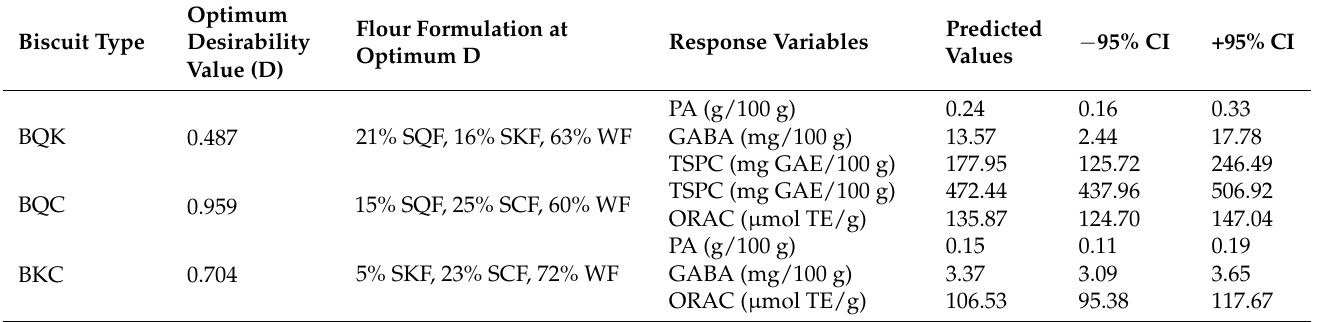
Table 4. Composition of flour blends and predicted values for PA, GABA, TSPCs, and ORAC in biscuits at optimum desirability value (D).